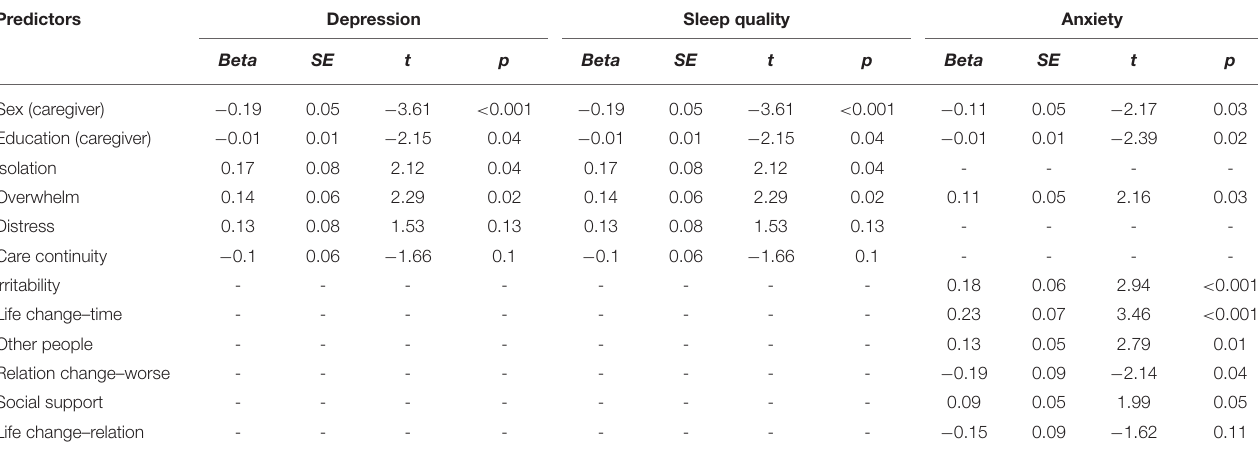
TABLE 2 | Variables included in the predictive model for depression, sleep quality and anxiety levels at T2.